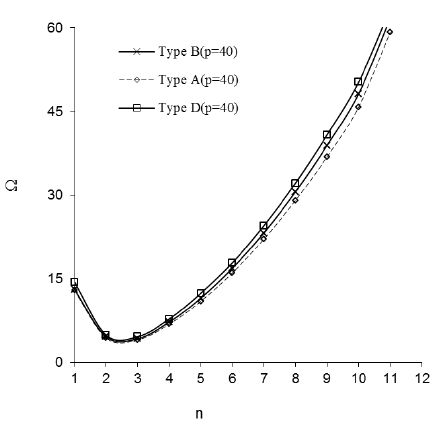
ation of frequency values with mode number of SS shell for different constituent of material is given in Figure 5 for S-S shell. Freqeuncies values are firstly decrased (for n=1,2,3) and increasing rapidly with the mode numbers, as similar to the isotropic one.